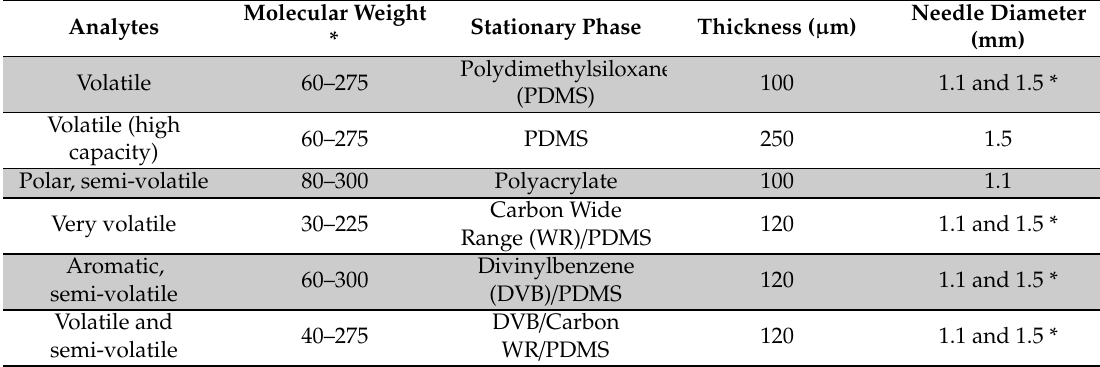
Table 2. Current SPME Arrow phase